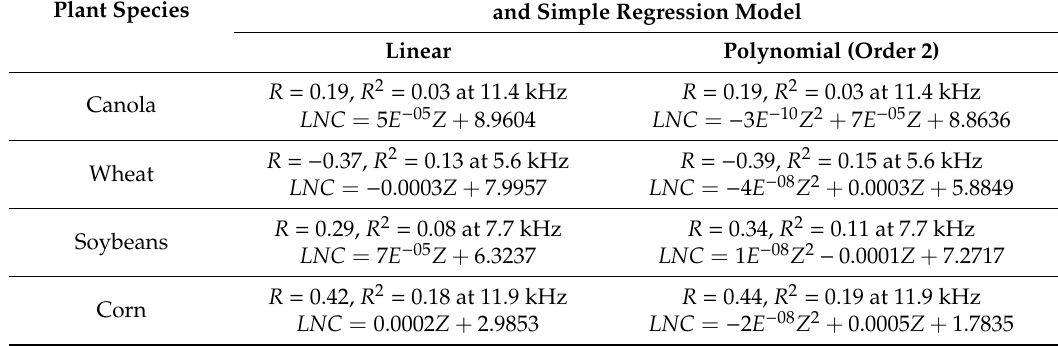
Table 1. Correlations between leaf nitrogen concentration (LNC) and leaf impedance ( Z ).for different plant species.